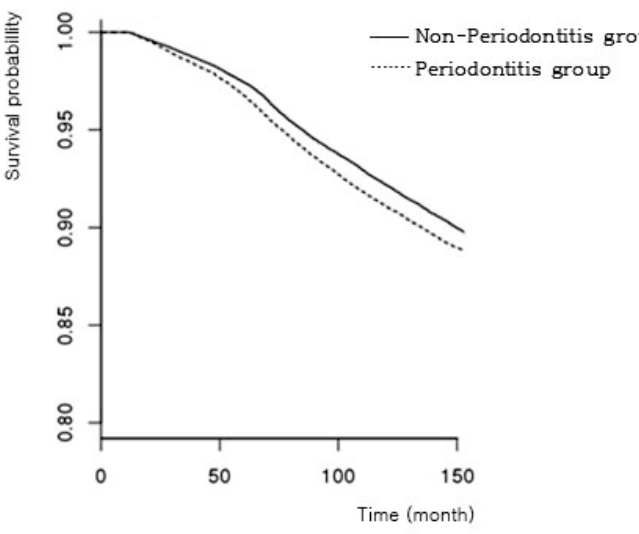
Figure 3. Kaplan–Meier curves for the incidence of ACVD by the presence of periodontitis.